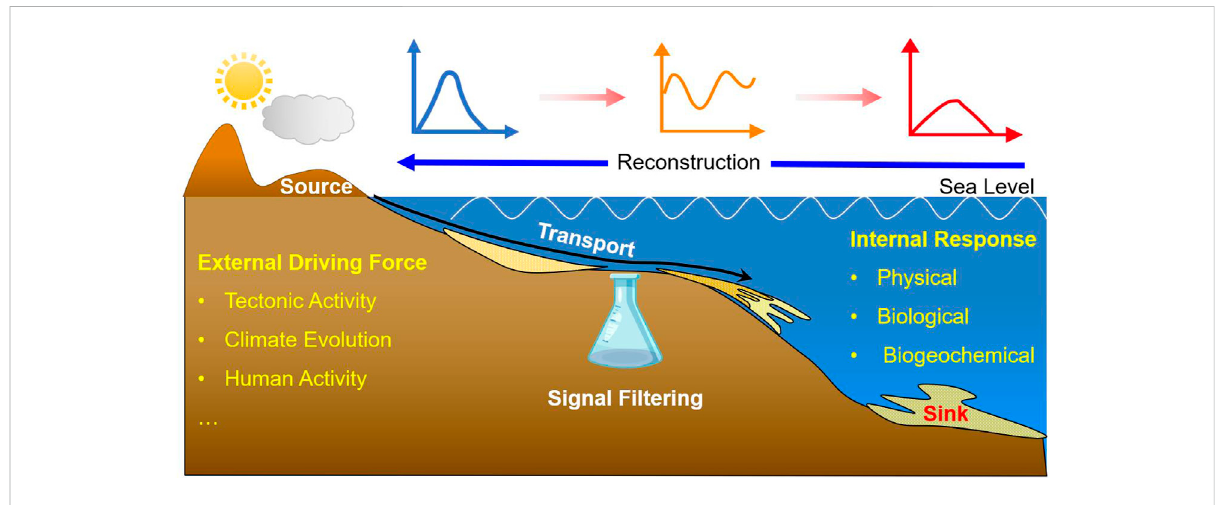
FIGURE 1 Schematic diagram of the sedimentation process and depositional record on the continental